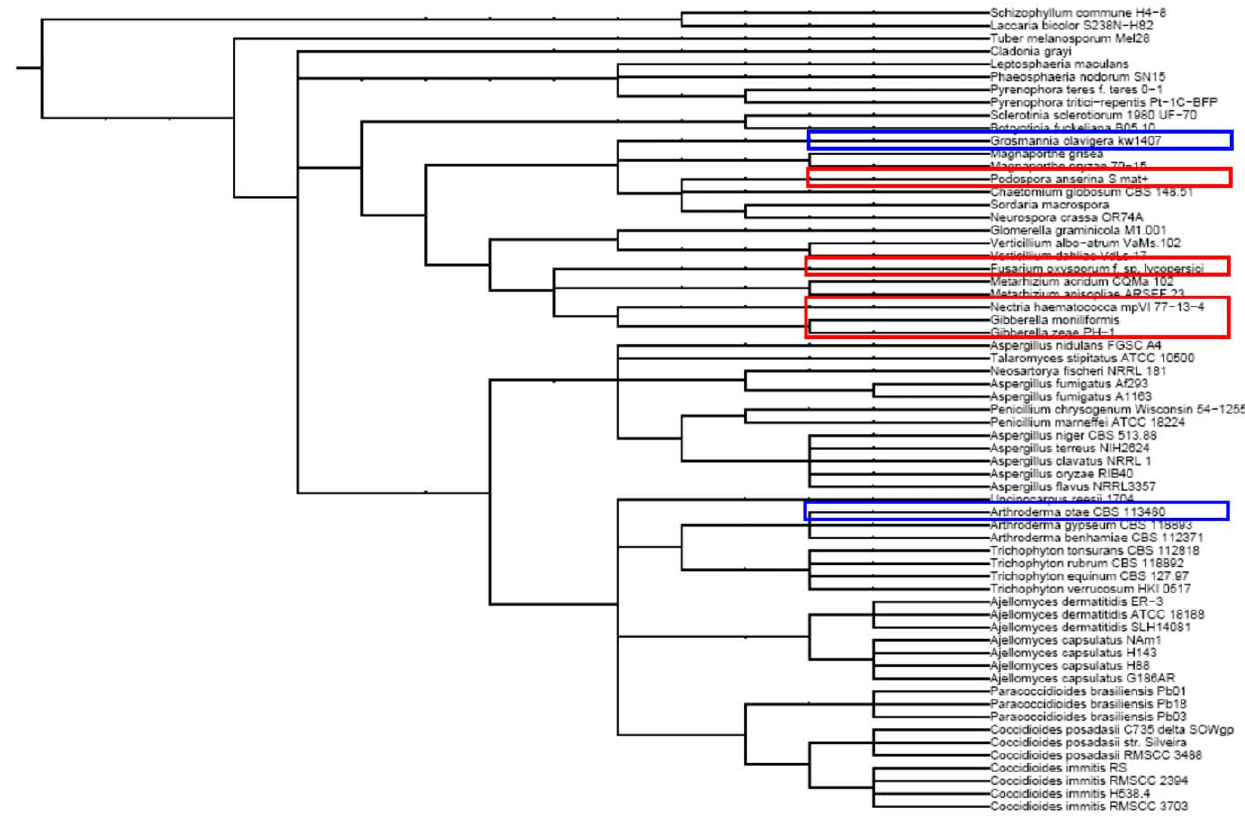
Figure 6. Taxonomic lineage of homologs to the N-Term domain. Species with proteins homologous to the prion domain are highlighted in the red box. The marginal additional homologs observed in Grosmannia clavigera and Arthroderma otae are highlighted in the navy boxes.